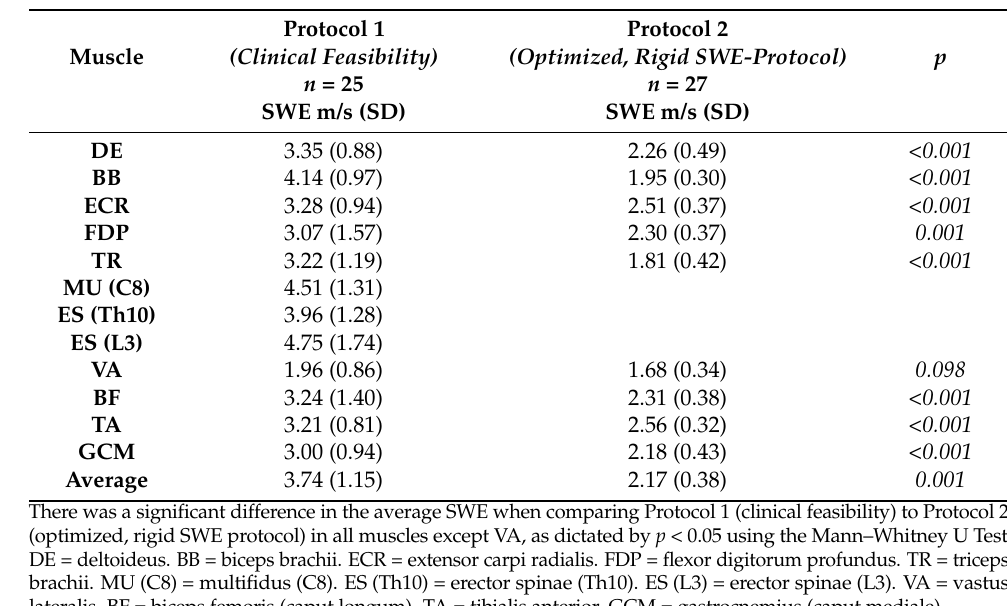
Table 3. Summary of the average SWE in m/s and standard deviation (SD) for each muscle examined in all protocols and groups of this study.